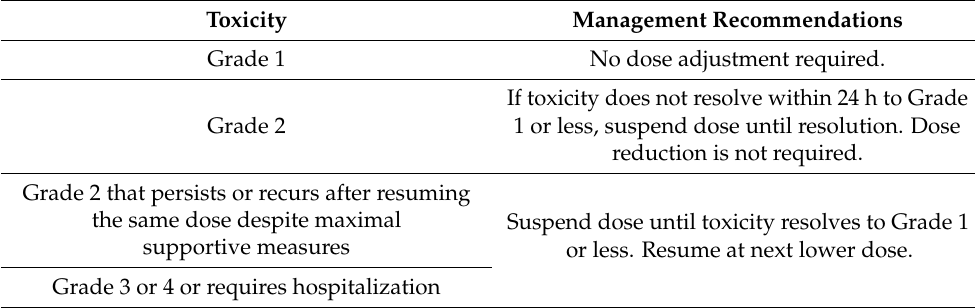
Table 3. Dose modifications and management of diarrhea caused by abemaciclib, according to abemaciclib US prescribing information, accessed in March 2023.